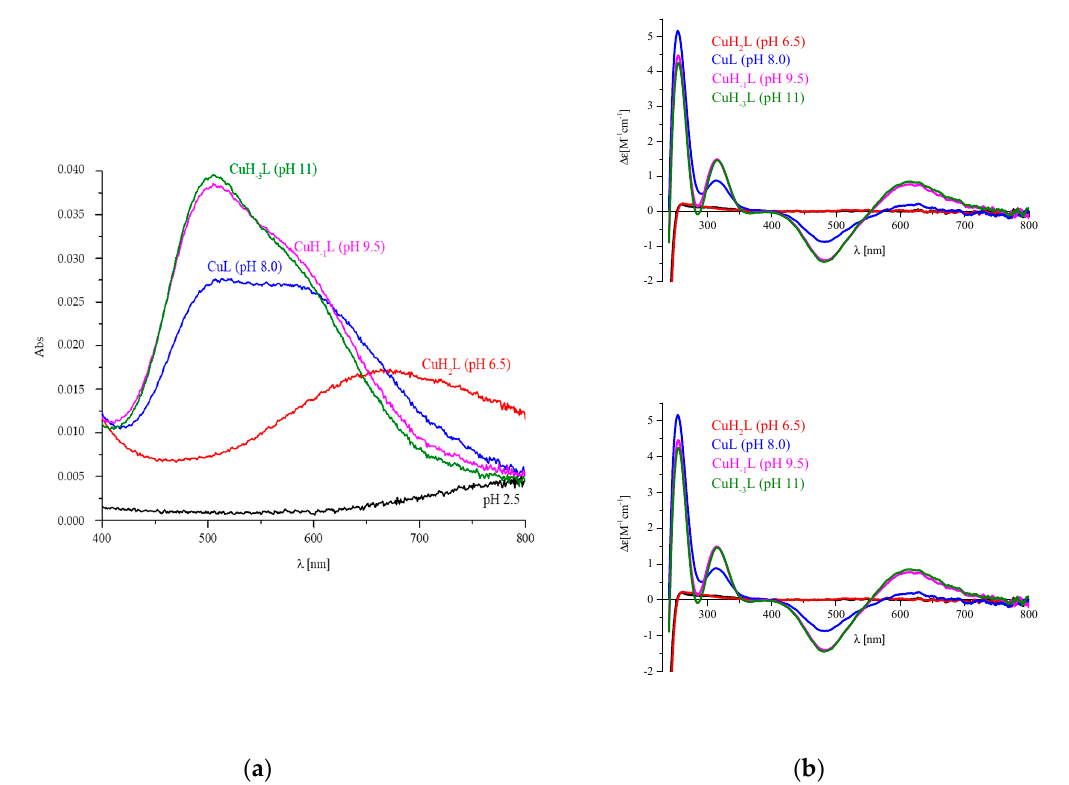
Figure 3. Spectra for Cu(II)/P1 system: ( a ) UV-Vis; ( b ) circular dichroism (CD). The ligand concentration was 7×10 − 4 mol/L and pH-metric titration was performed in a 0.3 mol/L KCl solution using sample volumes of 2 mL. Measurements were carried out in a 2.5–10 pH range, at 25 °C. The pH values were established by adding small amounts of concentrated KOH and HCl solutions. The ligand to metal ratio was 2:1.